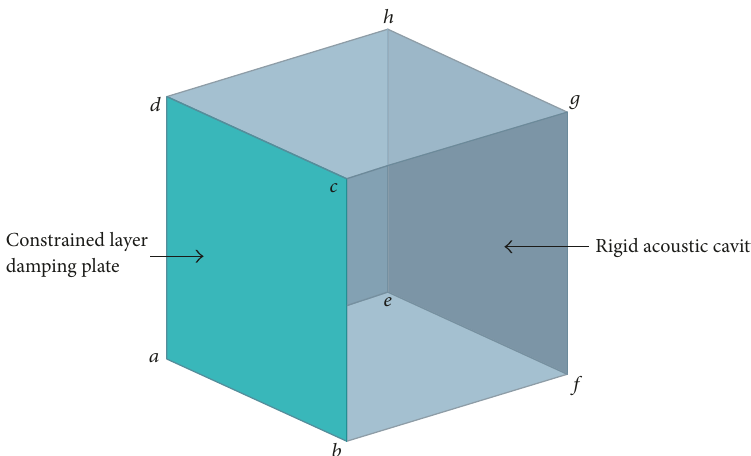
Figure 1: Schematic drawing of a closed acoustic